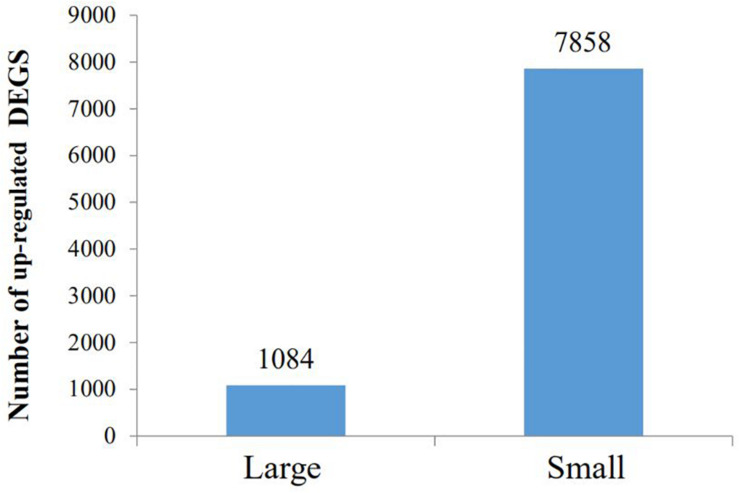
The GO analysis of different expression genes. The 5150 differentially expressed genes were divided into three groups, respectively, biological process (1530), cellular component (1737), and molecular function (1883).